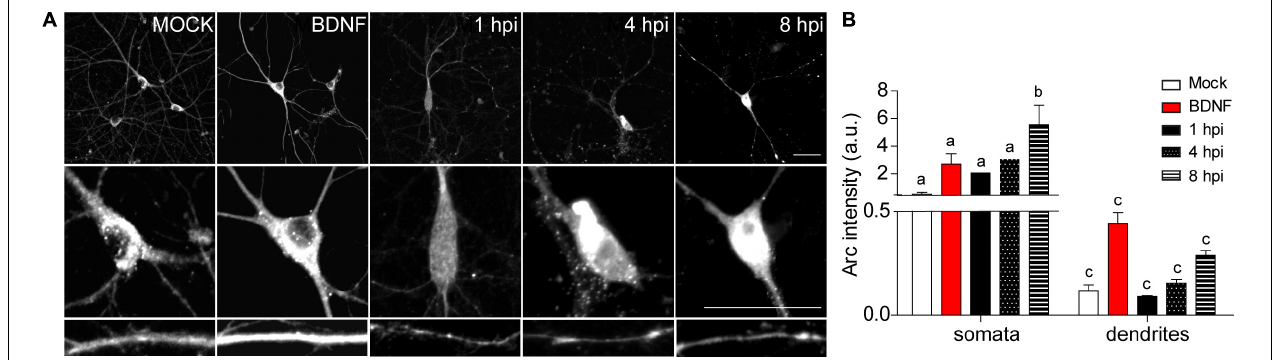
FIGURE 3 | HSV-1-induced Arc is enriched in neuronal somata rather than dendrites of infected neurons. (A) Immunocytochemical analyses of Arc protein subcellular distribution during infection kinetics. Middle and low panels show magnifications of somata and dendrites. Scale bars: 20 µ m (B) Quantification of Arc fluorescence intensity in HSV-1 infected neurons versus positive (BDNF) and negative (Mock) controls. Statistical significance was determined by One-Way ANOVA, followed by Tukey’s test. Bars represent the mean ± SD of biological replicates (10 neurons per treatment). Different letters above the mean bars apply to significant differences between groups p < 0.05. The images and quantifications are representative of three independent